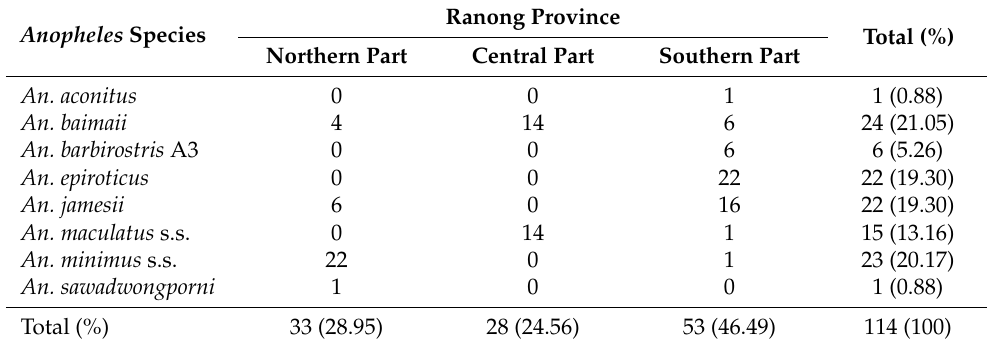
Table 1. Species and numbers of Anopheles sampled in the geographical region of Ranong province, Thailand (January–June 2022), identified using molecular